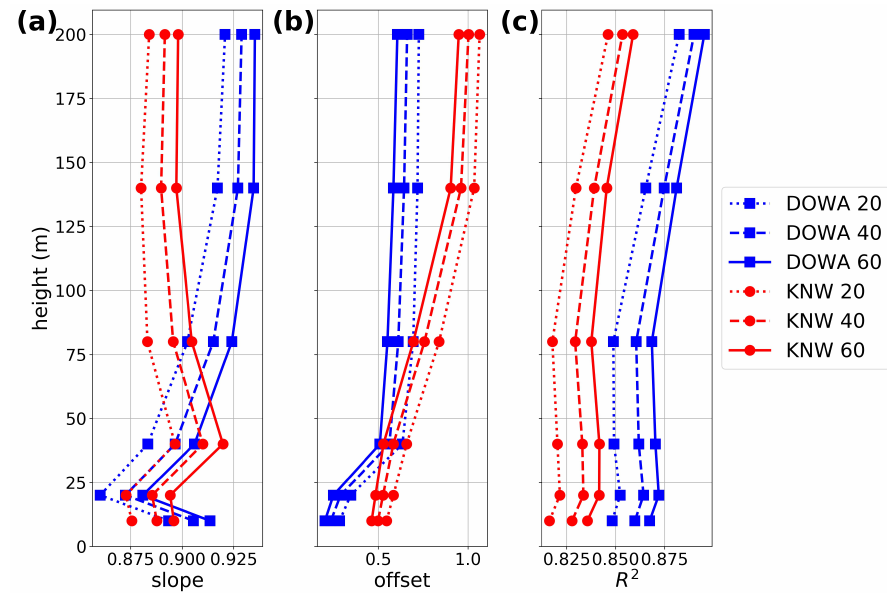
Figure A2. Height profile of the results of the linear regression ( a ) slope, ( b ) offset and ( c ) R 2 of the wind speed data, comparing the DOWA (blue) and KNW atlas (red), for different averaging times (20, 40, and 60 min) of the mast